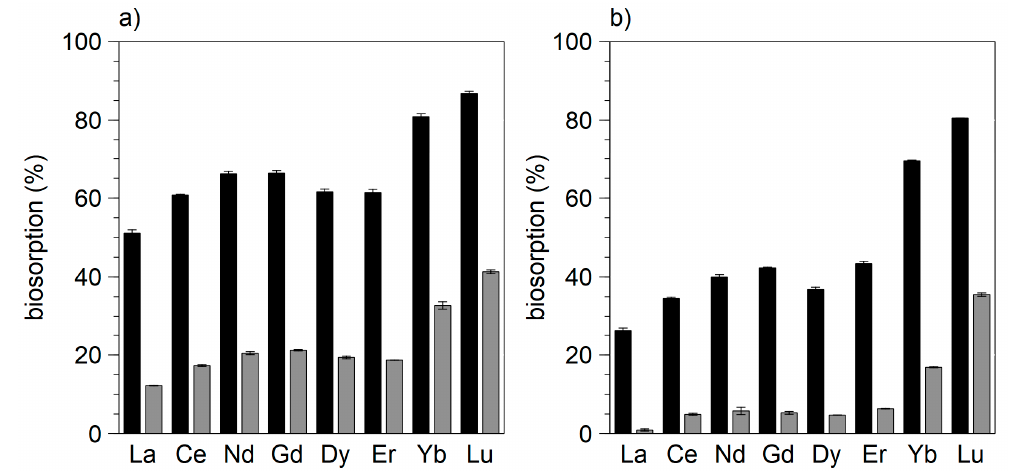
Figure 3. Biosorption of REEs by L. methylohalidivorans ( a ) and P. inhibens ( b ). BM 2.5 g / L (grey) and 5 g / L (black), initial REE concentration was 15 µ mol / L for each element, sampling took place after 2 h. Bars show mean of two parallel assays, error bars show standard deviation.